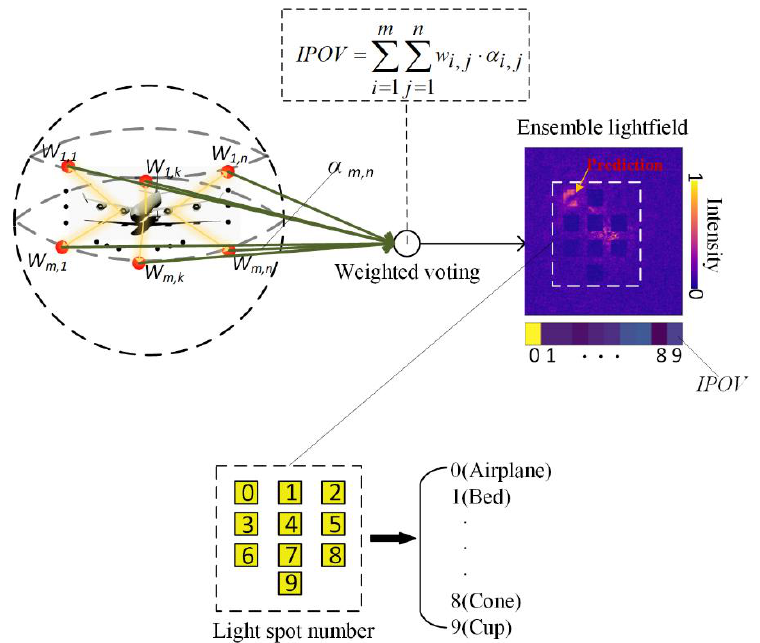
Figure 5. Schematic diagram of the mr-MDA.